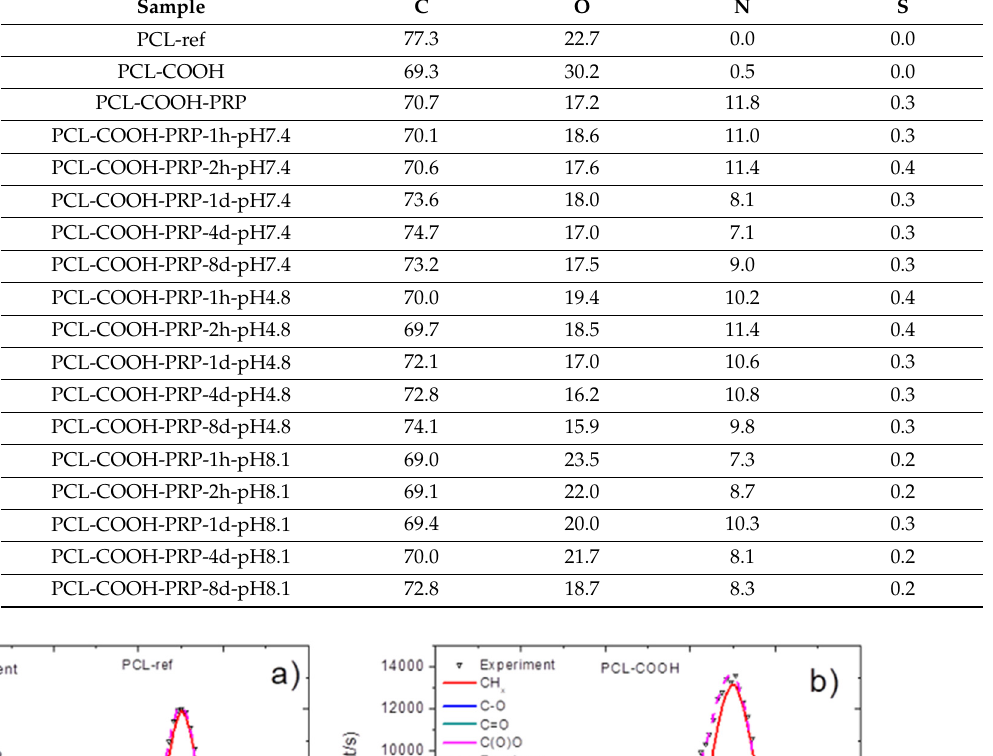
Table 1. Atomic composition of samples determined by XPS analysis.